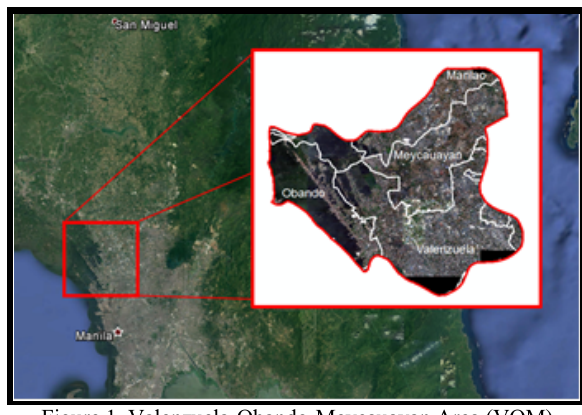
Figure 1. Valenzuela-Obando-Meycauayan Area (VOM)